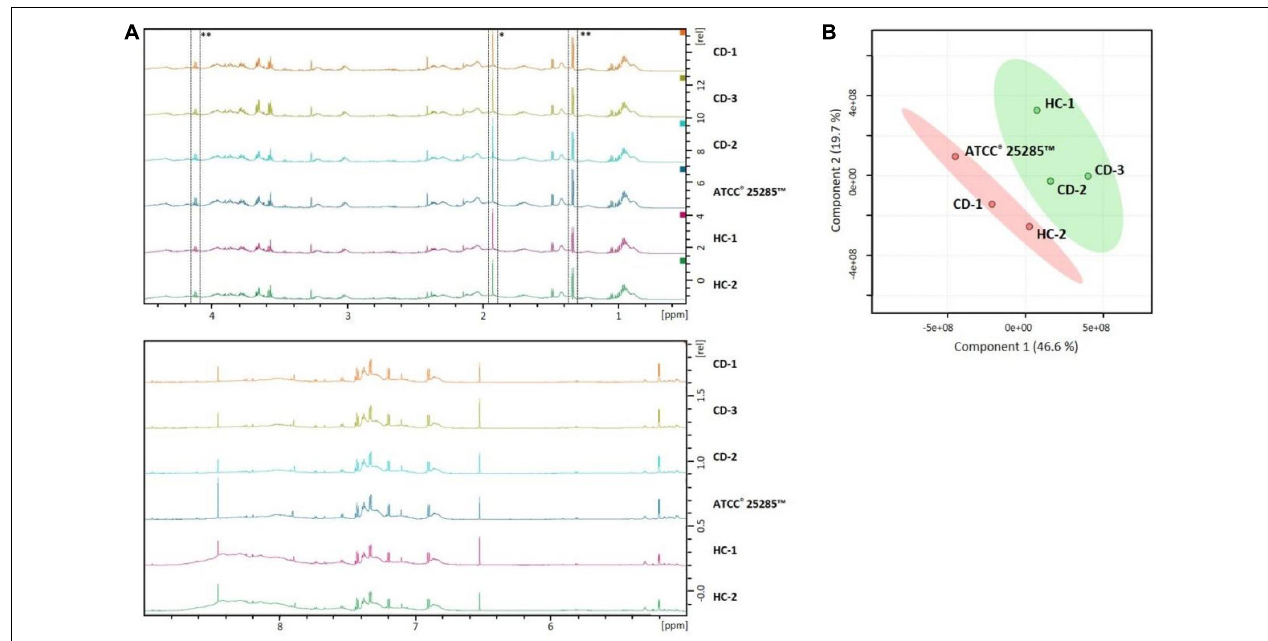
FIGURE 5 | NMR profiles of B. fragilis supernatant can distinguish between TEER-enhancing and non-TEER-enhancing strains. (A) The NMR spectra of all strains are largely comparable. Acetate (*) and lactate (**) is relatively decreased in the TEER-enhancing B. fragilis strains HC-1, CD-1, and CD-3 compared to all other strains. (B) PLS-DA plot demonstrates that the TEER-enhancing group (green) can be clearly discriminated from the non-TEER-enhancing (red)